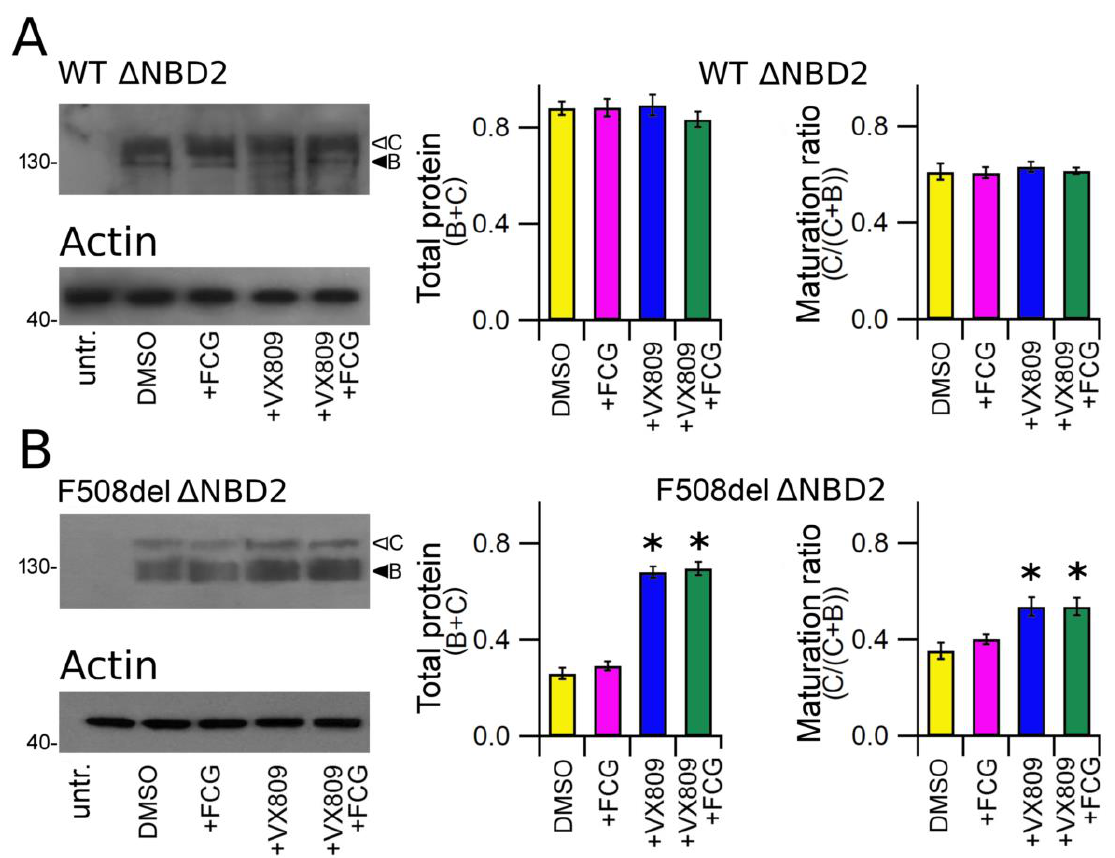
Figure 4. Biochemical analysis of WT and F508del ∆ NBD2 expression pattern. ( A ) Electrophoretic mobility of WT ∆ NBD2 in untransfected and in HEK-t cells treated with DMSO (vehicle control) or with FCG, VX809 and FCG + VX809, respectively. ( B ) Western blot of whole cell lysates of F508del ∆ NBD2 untransfected and F508del ∆ NBD2 transfected cells after 24 h of treatment with the above-mentioned compounds. Arrowheads indicate the fully glycosylated (band C) and the core- glycosylated (band B) forms of the ∆ NBD2 proteins, respectively. The blots in the bottom show the expression of actin, used as housekeeping protein. The molecular weight of the proteins of the molecular weight marker that was run in the SDS-PAGE is indicated on the left of each blot. Bar graphs in the middle show the quantification of the total ∆ NBD2 protein expression, calculated as the sum of bands B and C. Bar graphs on the right indicate the quantification of the mature, fully glycosylated fraction of the ∆ NBD2 protein, expressed as C/(C + B) band ratio. Data are expressed as means ± SEM of at least four independent experiments. Statistical significance was tested by Dunnett’s multiple comparisons test (all groups against the control group). Asterisks indicate statistical significance versus DMSO: * p <